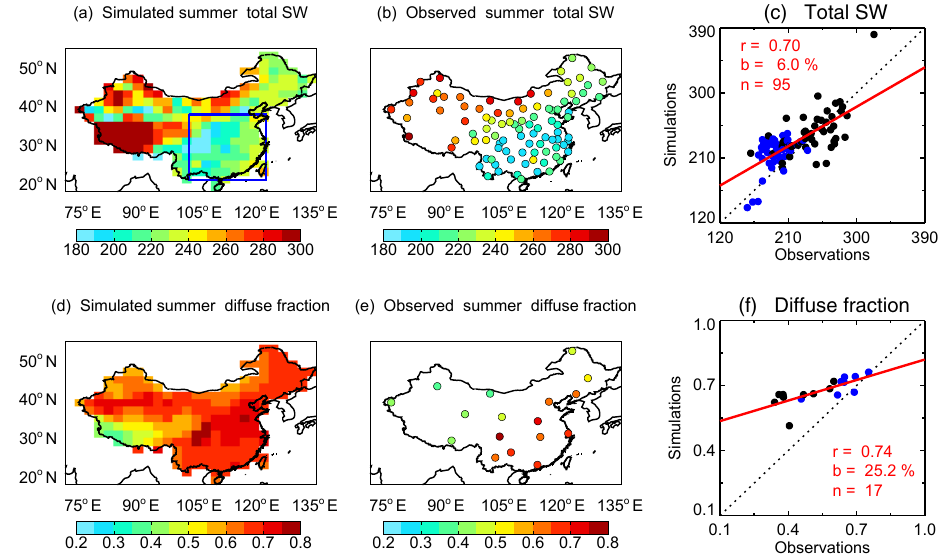
Figure 4. Evaluation of simulated radiation fluxes by ModelE2–YIBs. Panels show summertime surface (a) total shortwave radiation (units: Wm − 2 ) and (d) diffuse-to-total fraction with (b, e) observations from 106 sites. Simulation results are from G10ALLNO3 performed with the climate model ModelE2–YIBs (Table 2). The correlation coefficients ( r ), relative biases ( b ), and number of sites ( n ) for the comparisons are listed on the (c, f) scatter plots. The blue points in the scatter plots represent sites located within the box regions in southeastern China as shown in panel (a).